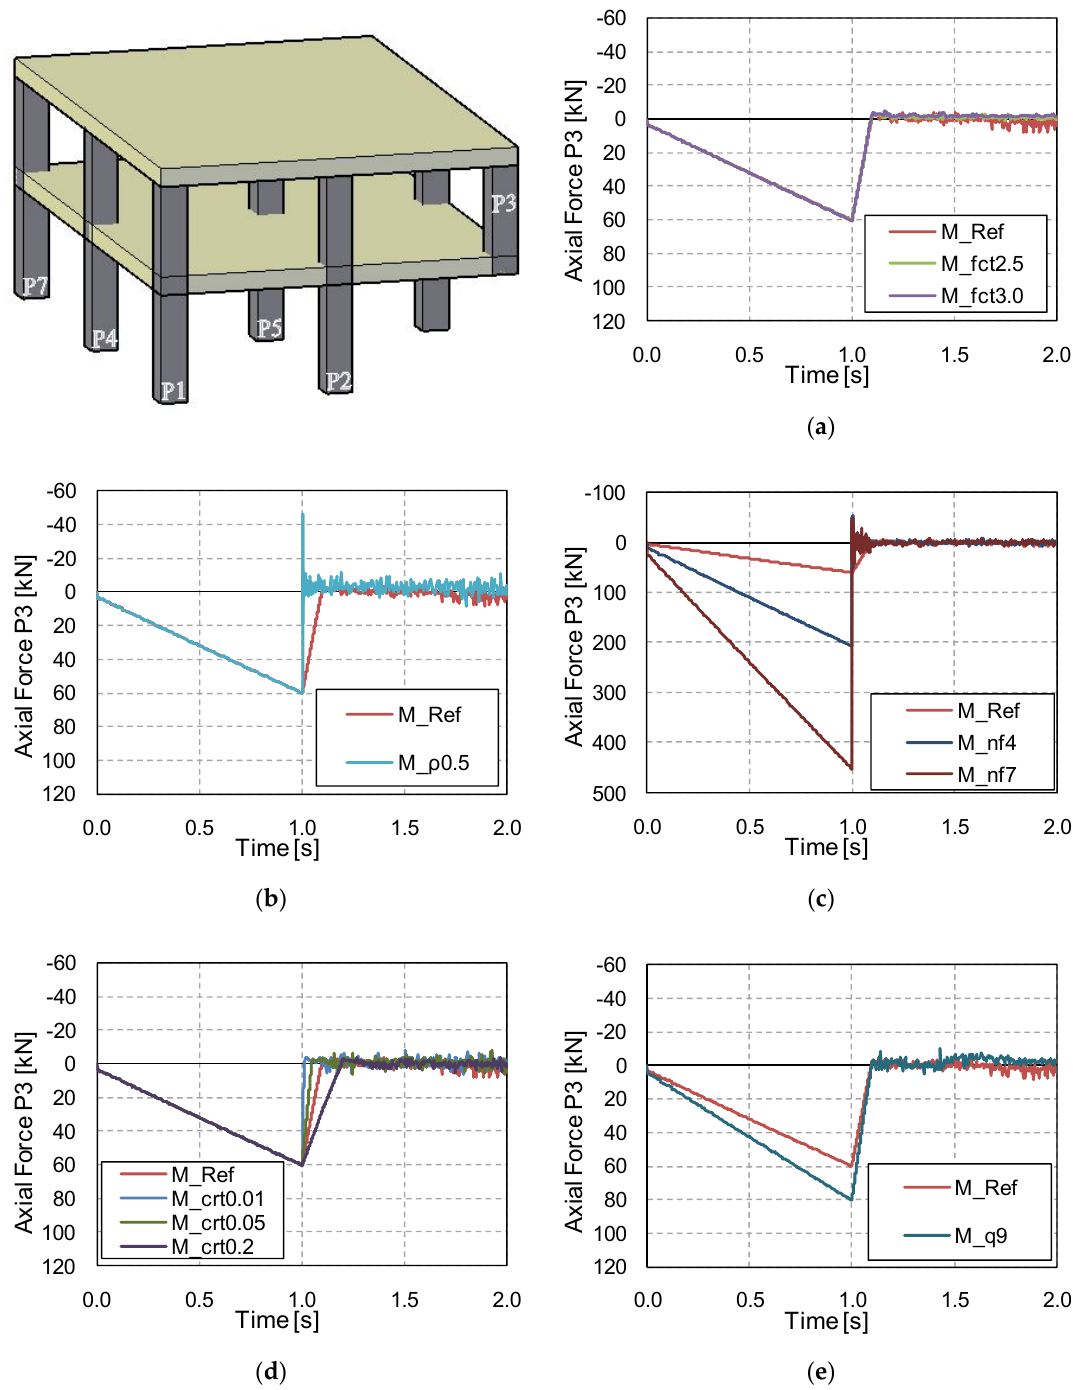
Figure 10. Numerical axial force in P3 (first floor) obtained by varying ( a ) concrete tensile strength, ( b ) flexural reinforcement ratio, ( c ) number of floors, ( d ) column removal time and ( e ) superimposed load. Positive values indicate compression.